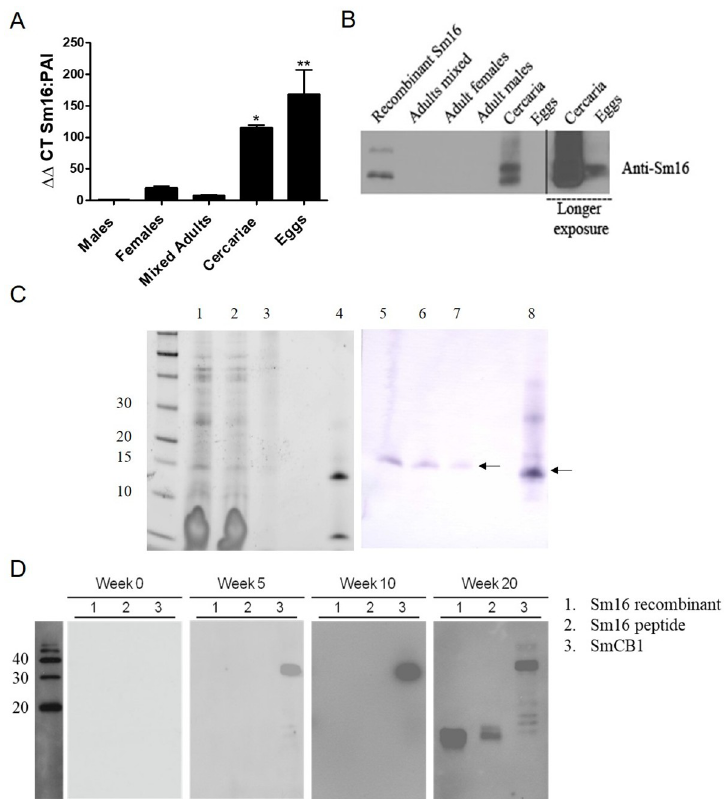
Fig 3. Sm16 is expressed in S . mansoni cercariae and eggs. (A) qPCR was used to assess the expression of Sm16 mRNA in S . mansoni adults (males, females, and mixed), cercariae and eggs. ΔΔ Ct values were normalised to the level of PAI expression in samples (3) and presented as relative to the level of Sm16 expression in male adult schistosomes and analysed by ANOVA with Tukey’s multiple comparison test. � p < 0.05, �� p < 0.01. (B) Western blot carried out using 5 μ g of crude extract from S . mansoni adults (mixed, females and males) cercariae and eggs and probed with an anti-Sm16 antibody. (C) SDS-PAGE analysis (lanes 1–4) and Western blot (5–8) of soluble extracts of cercariae (1 and 5), newly-transformed schistosomula (2 and 6), concentrated transformation medium (3 and 7) and recombinant Sm16 (4 and 8) (D) Blood samples were taken from mice with experimental schistosomiasis at 0, 5, 10, and 20 weeks post infection and sera was used to probe Western blots of recombinant Sm16, synthetic peptide Sm16 (34–117), and recombinant S . mansoni cathepsin B1 (SmCB1) (1 μ g of